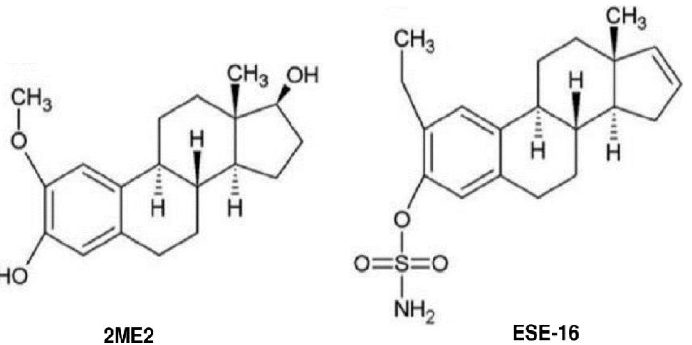
Figure 1. Chemical structures of 2-methoxyestradiol (2ME2) and 2-ethyl-3- O -sulfamoyl-estra- 1,3,5(10)16-tetraene (ESE-16). The parent compound 2ME2 differs from the analogue ESE-16 with respect to a 2′ ethyl group, 3′ sulfamoylation, and a 17′ alteration.